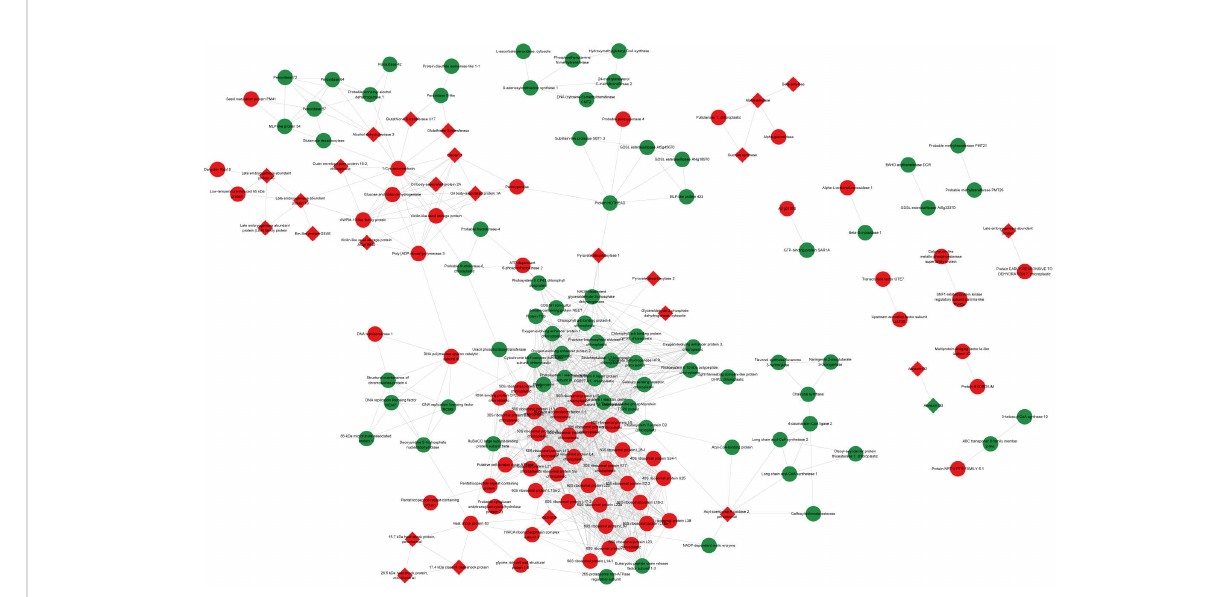
FIGURE 4 Protein – protein interaction (PPI) network of differentially accumulated proteins in quinoa seeds during maturation. The nodes in green represent downregulated proteins, and those in red represent upregulated proteins. The diamond nodes were considered to be key proteins in seed maturation by searching the relative study and database.